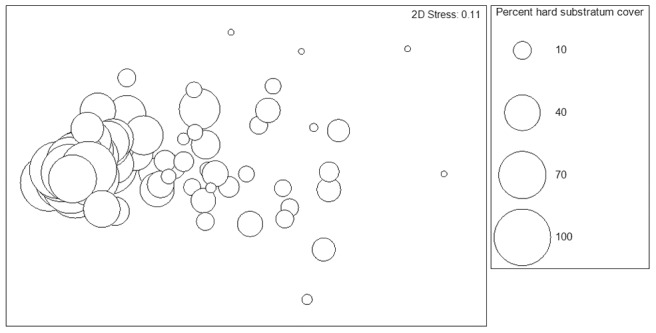
MDS bubble plot depicting megafaunal composition according to percent hard substratum cover.Data have been fourth-root transformed. A 2-D stress value of 0.11 indicates a good fit of the data.